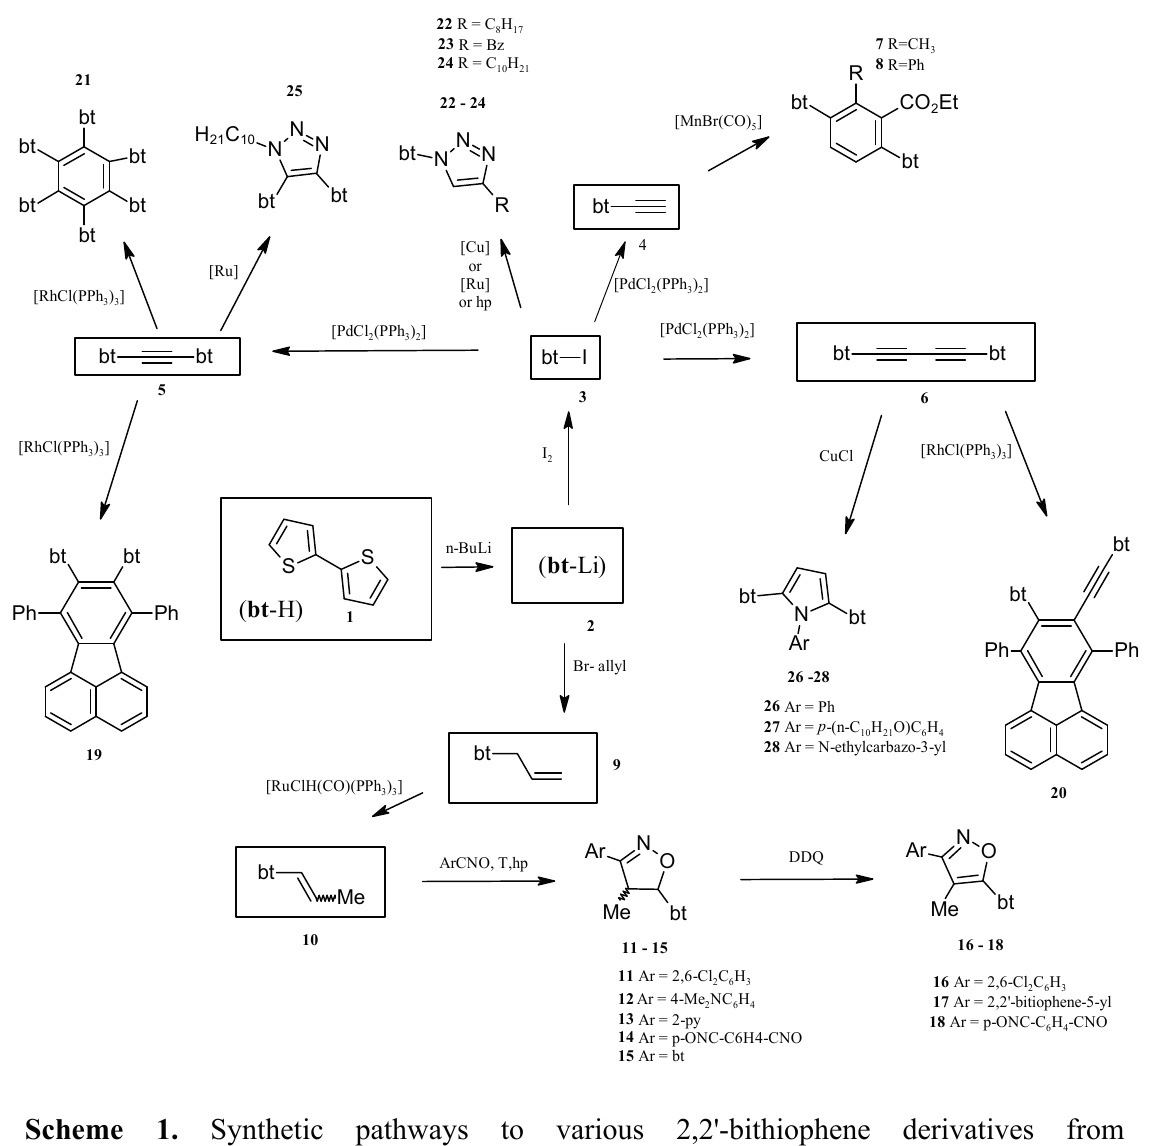
Synthetic pathways to various 2,2'-bithiophene derivatives